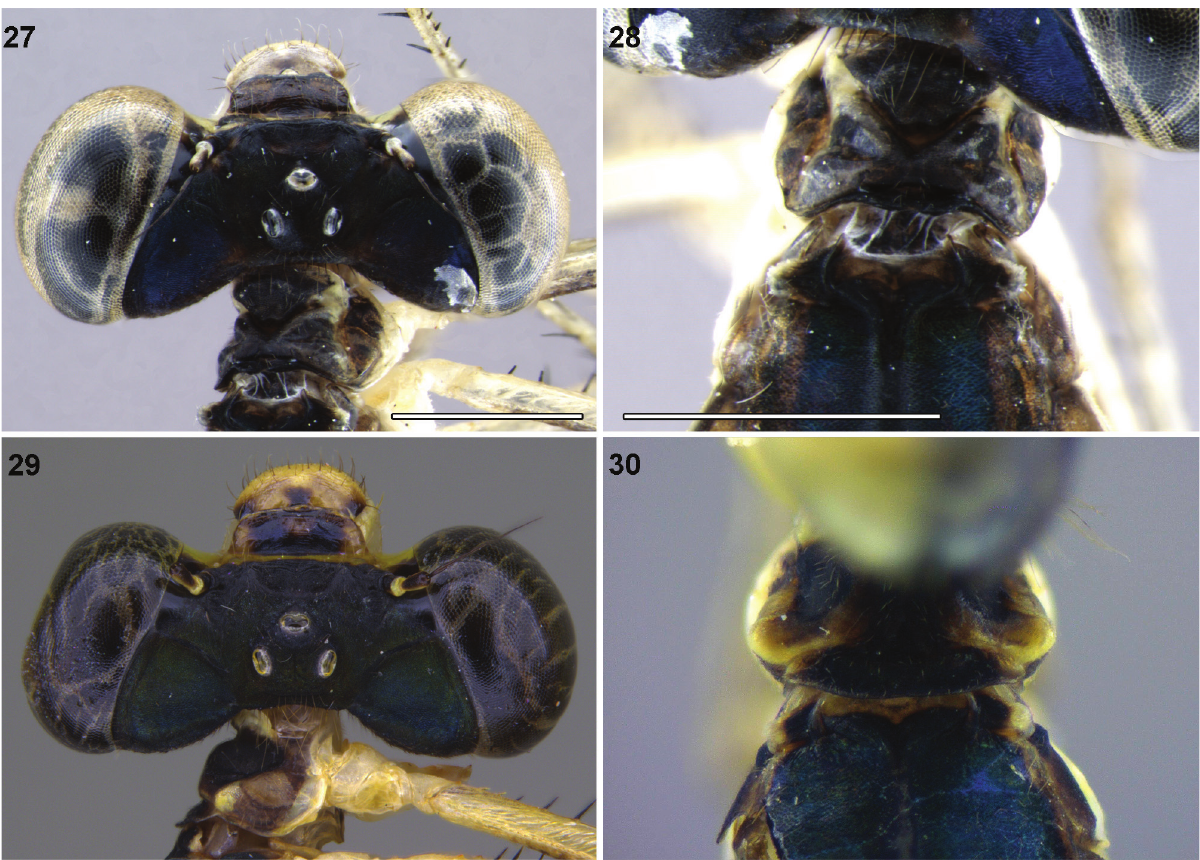
Figures 27–30. Head and prothorax in dorsal view of females of Forcepsioneura : (27–28) F. regua sp. nov., paratype (Brazil. RJ: